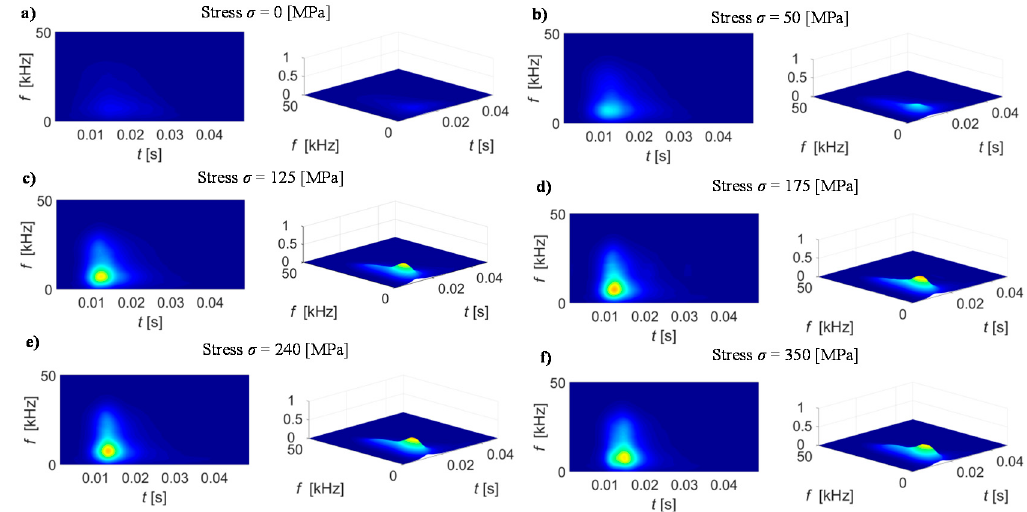
Figure 10. Comparison of the spectrogram in terms of different applied stress level (in [MPa]): ( a ) 0, ( b ) 50, ( c ) 125, ( d ) 175, ( e ) 240, ( f )